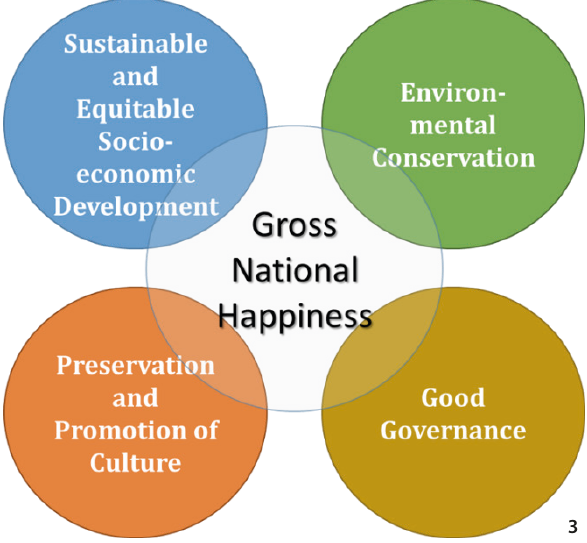
Figure 3 Four pillars to support the Gross National Happiness (GNH) of Bhutan—all of those are also the critical requirements to ensure the sustainability of the cultural landscape (Source: Mukai 2018).